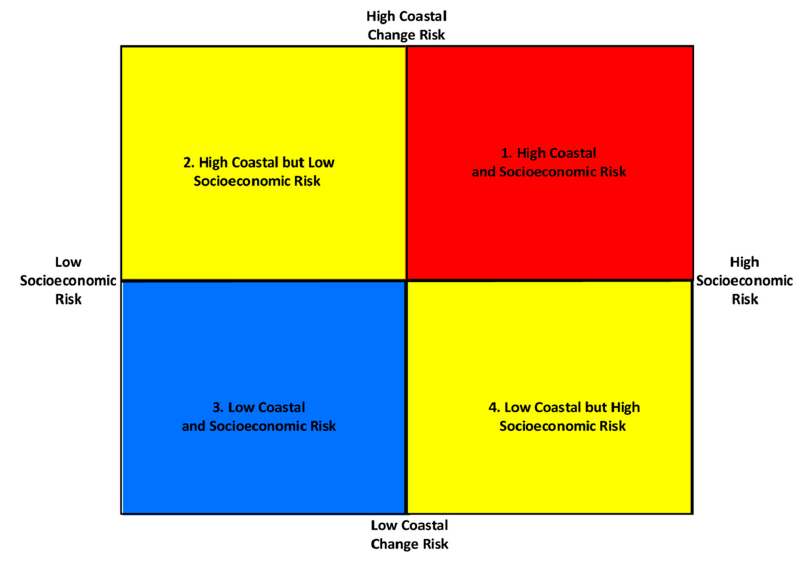
Figure 3. Typology for Assessing Vulnerability.